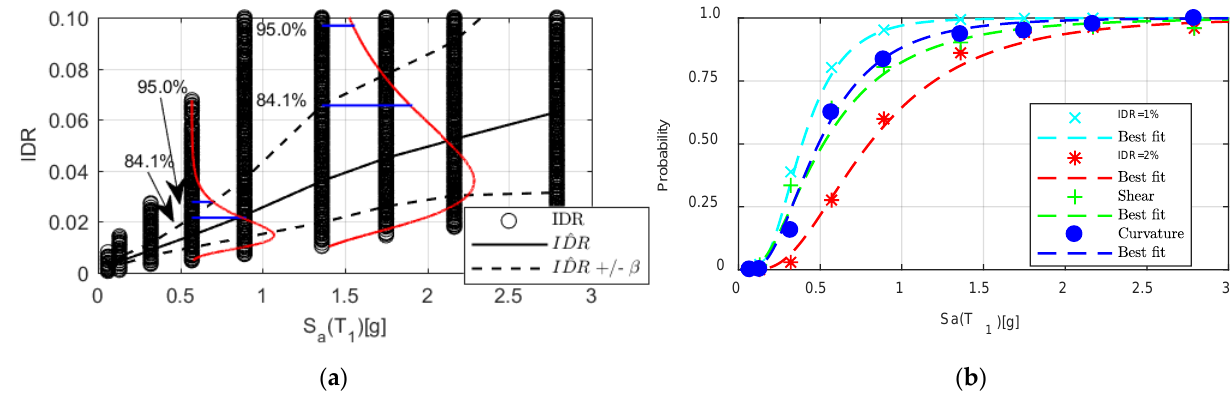
Figure 7. Multi-stripe analysis results for the 4-story case study building; ( a ) inter-story drift ratio demands obtained at each intensity level; ( b ) probability of limit state exceedance and associated fragility curve.